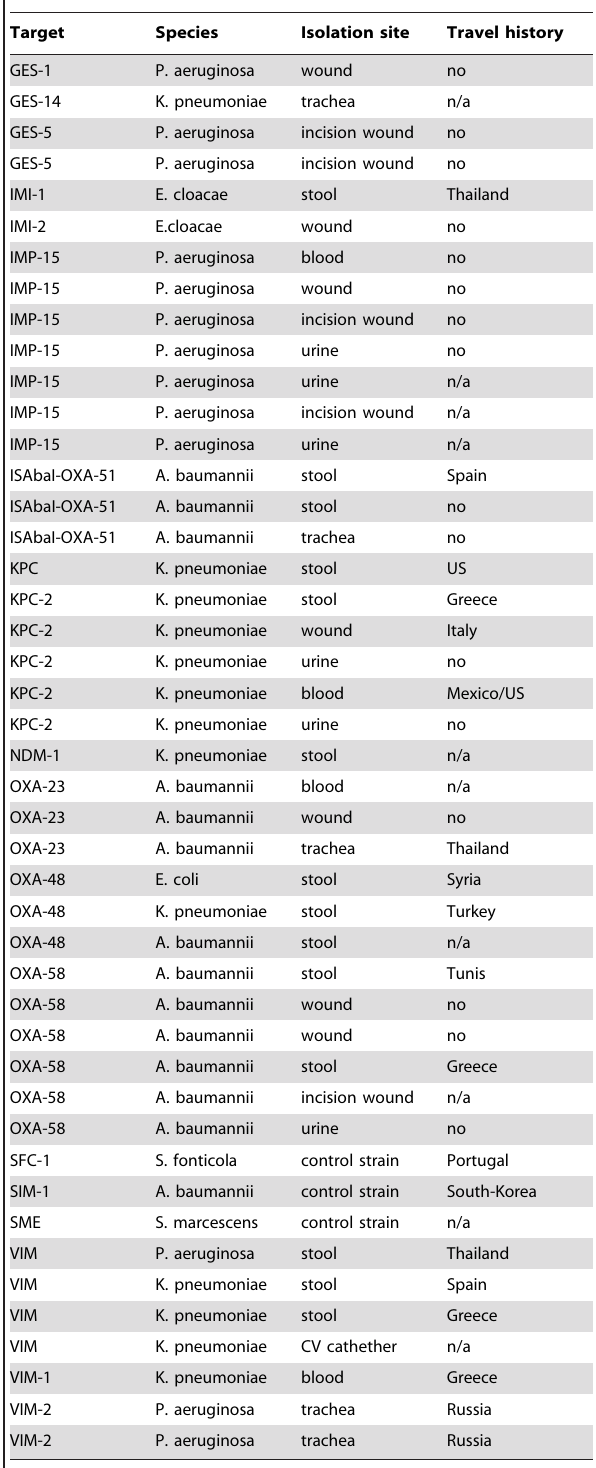
Table 1. Description of validation